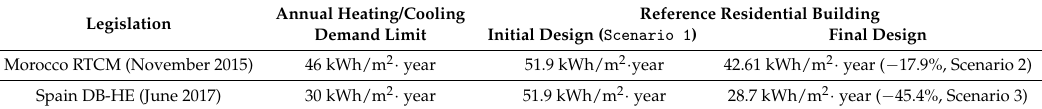
Table 9. Residential buildings’ annual heating and cooling demands: comparison and results.